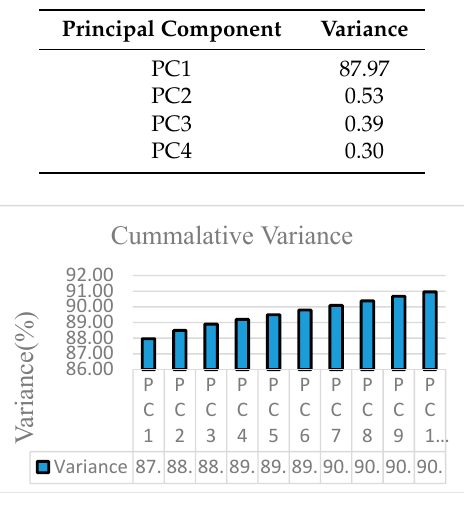
Figure 6. Cumulative variance of the first ten PCs.